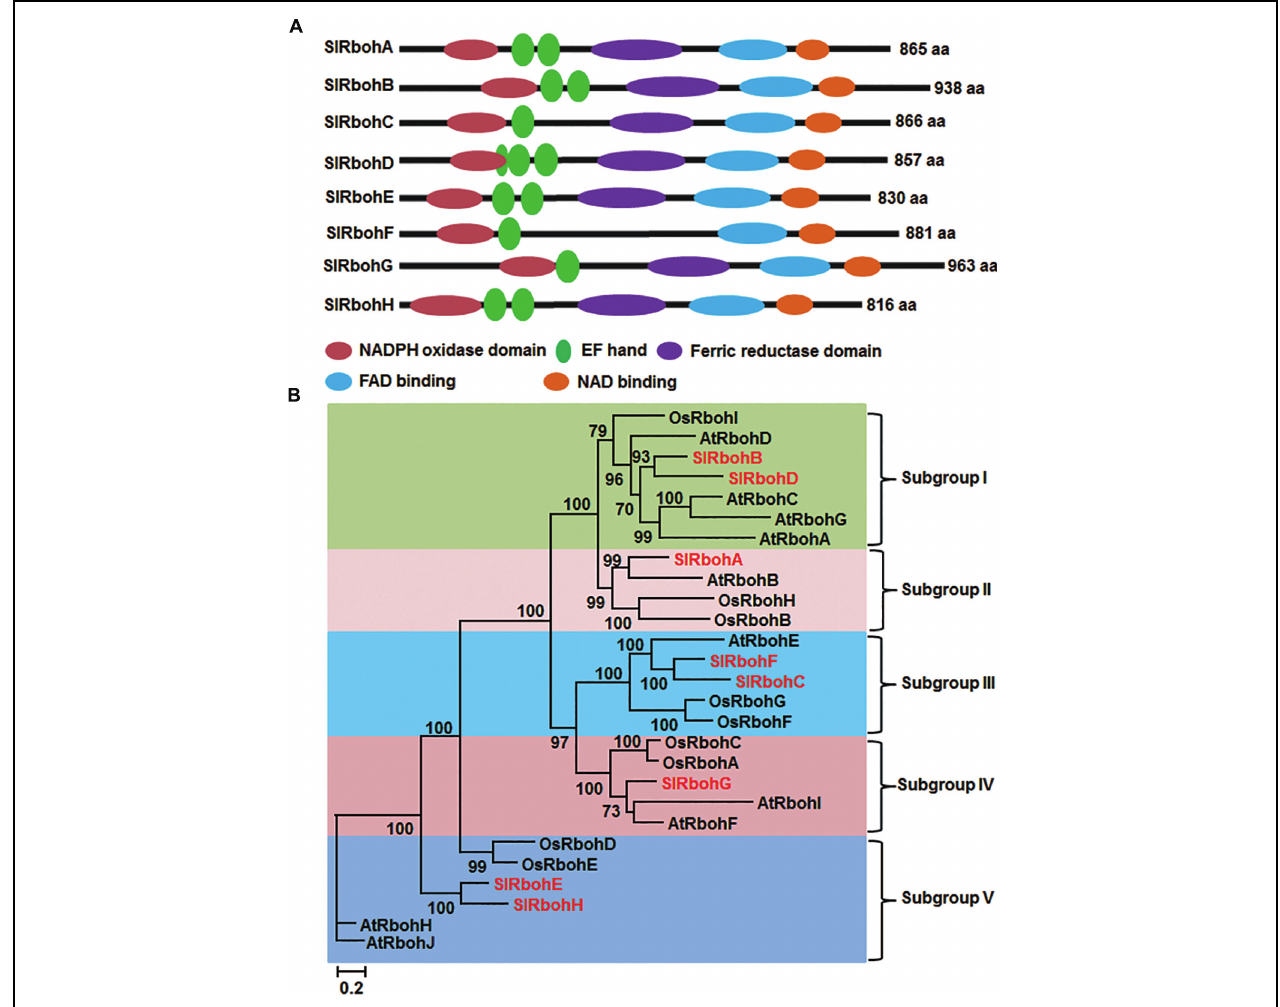
FIGURE 1 | Structure and phylogenetic tree of tomato Rboh proteins. (A) Functional domains and their organization in SlRboh proteins. (B) Maximum-likelihood (ML) tree of SlRbohs with Arabidopsis AtRbohs and rice